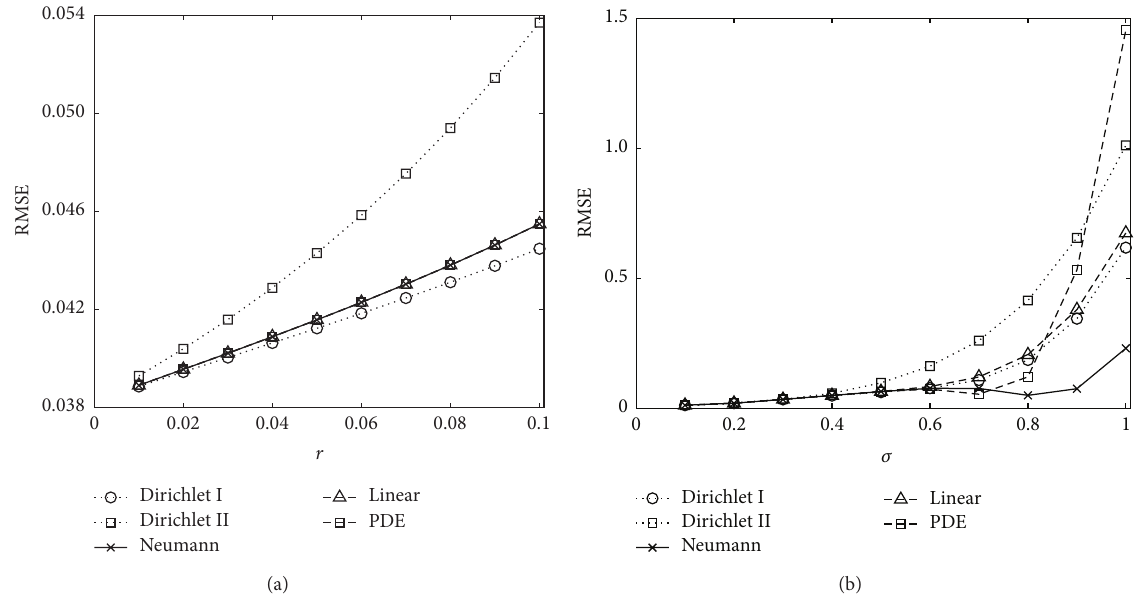
Figure 5: RMSE of various BCs versus (a) 𝑟 and (b) 𝜎 with European call option.